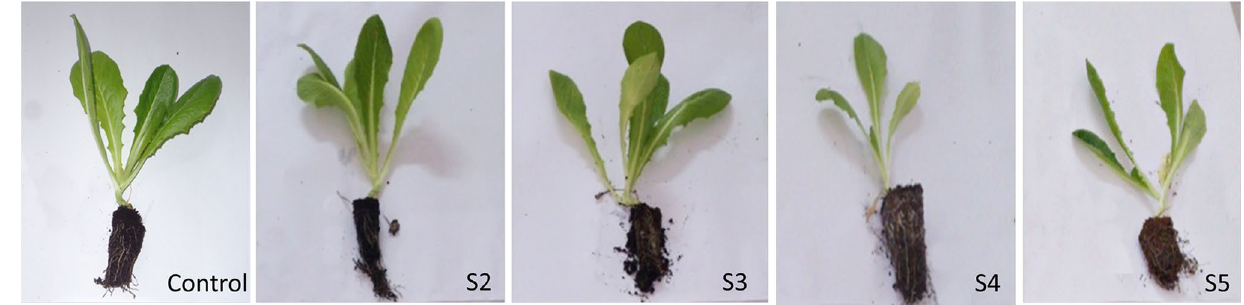
Fig. 1 Morphology of lettuce plantlets grown in different nursery substrates. S 1 = 100% Peat (Control), S 2 = 75% Peat + 25% palm-date wastes, S 3 = 50% Peat + 50% palm-date wastes, S 4 = 25% Peat + 75% palm-date wastes, S 5 = 100% palm-date